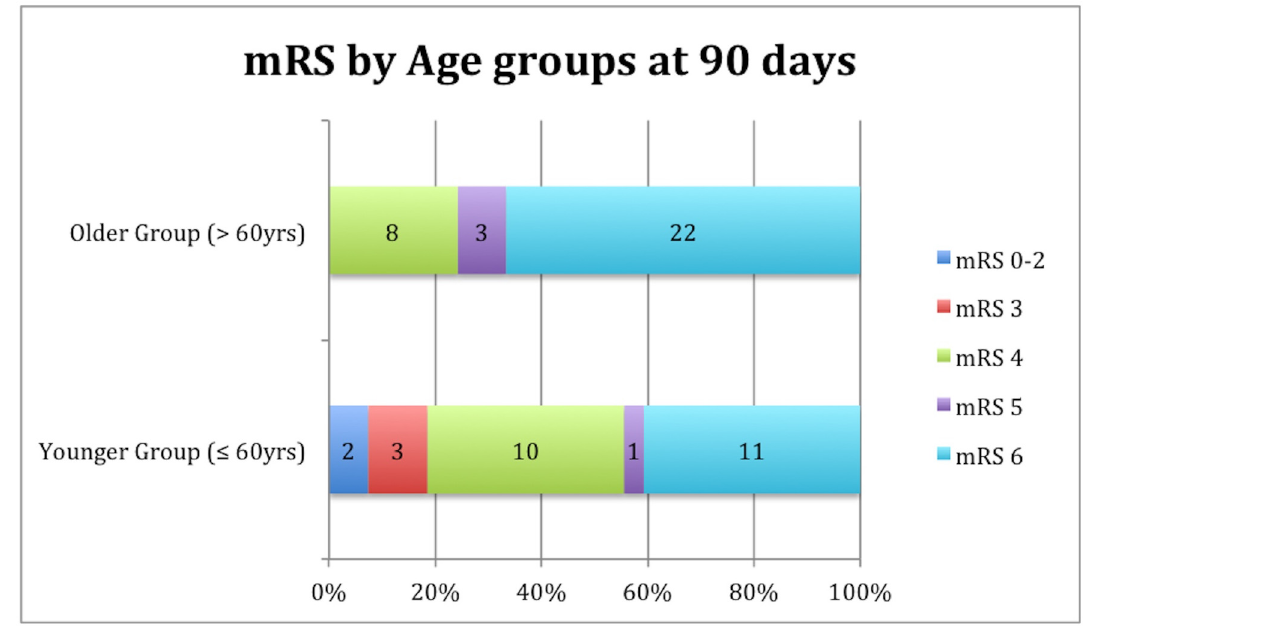
Fig 1. Functional outcome assessed by the modified Rankin score (mRS) at 90 days according to age